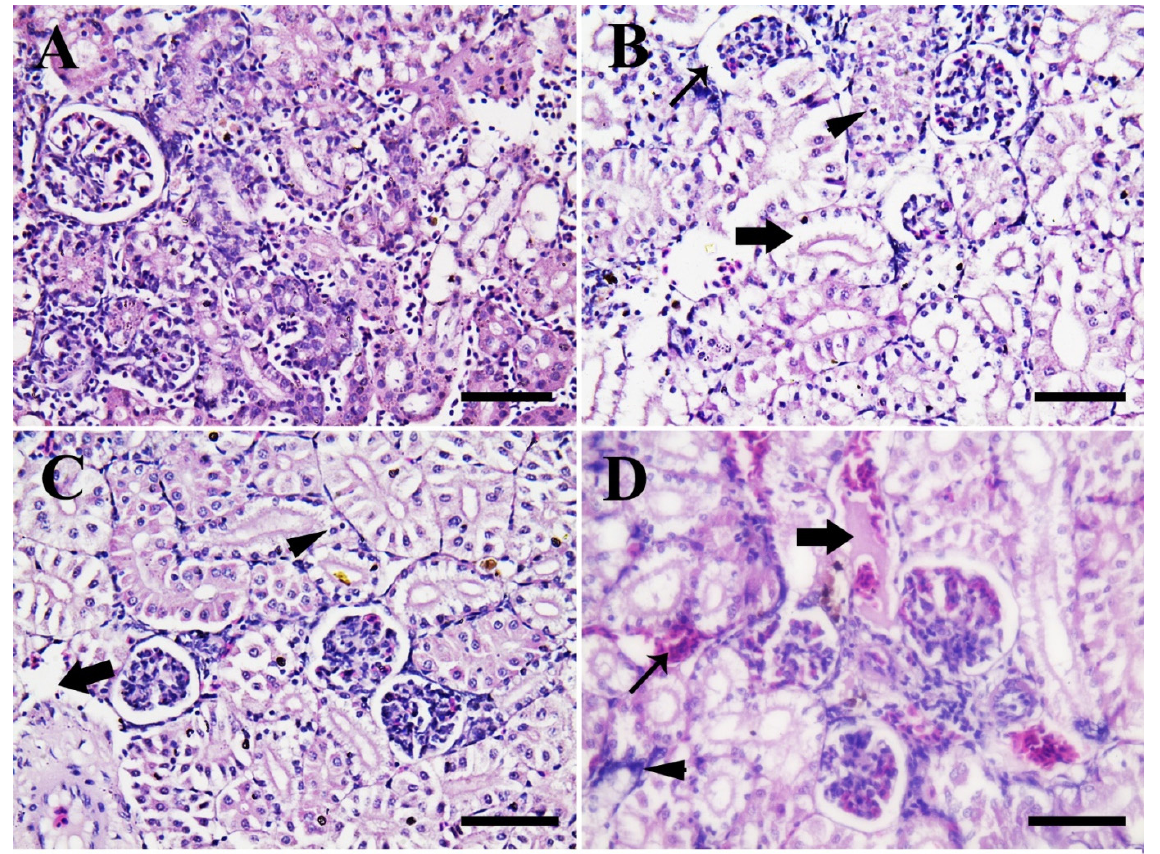
Figure 9. Representative photomicrographs in the posterior kidneys of Nile tilapia juveniles (H & E stain, scale bar = 50 µm) of the control group ( A ), and CuONPs-exposed fish at 10 mg/L ( B ), 20 mg/L ( C ), and 50 mg/L ( D ) values, respectively for 25 days. ( A ) shows normal renal architecture that consisted of renal tubules, renal lining epithelium, glomerulus, and bowman’s spaces. Meanwhile, ( B ) shows widened bowman spaces (thin arrow), widened renal tubules with slight necrosis of several renal tubules and edema (thick arrow), and pyknotic nuclei (arrowhead). ( C ) shows moderate necrosis of many renal tubules and edema (thick arrow), moderate distribution of pyknotic nuclei (arrowhead), and ( D ) shows intraluminal eosinophilic proteinaceous materials (thick arrow), inter-tubular congestion, multiple focal areas of inter-tubular hemorrhage (thin arrow), and inflammatory cells were widely distributed (arrowhead).